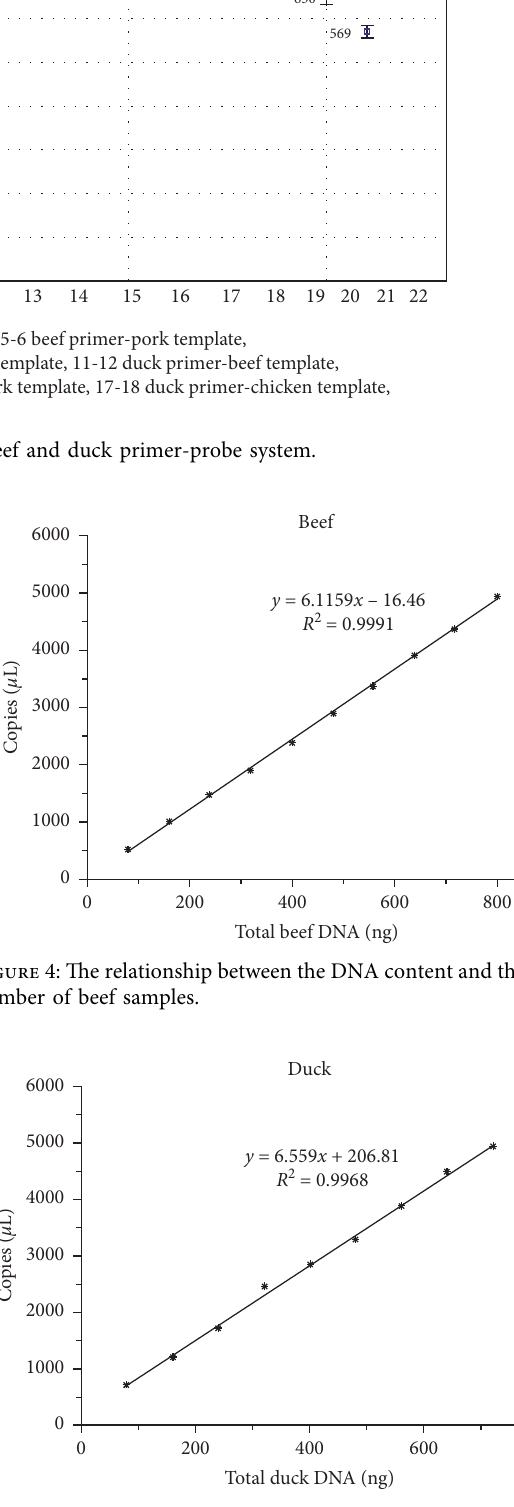
Figure 3: The relationship between the quality of raw meat and the DNA content of duck samples.